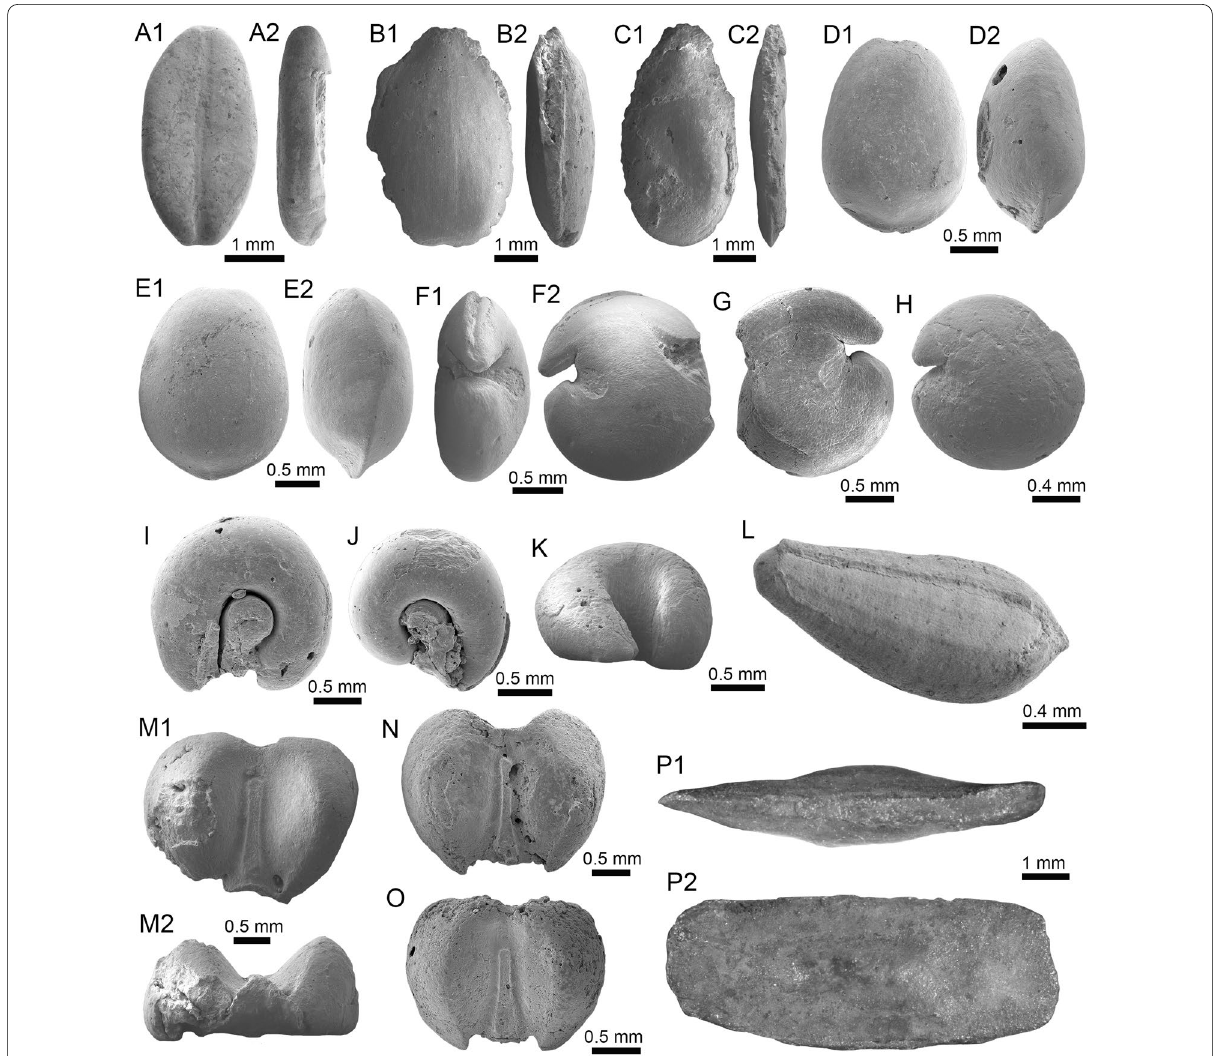
Fig. 33 Internal seed casts from the Norte Casa Chiguaje locality (Vergel Member). A1 , A2 Morphotype 1 (AMU‑PB‑02), Poaceae aff . Chloroideae. B1 – C2 Morphotype 2 (AMU‑PB‑03), Cucurbitaceae. D1 – E2 Morphotype 3 (AMU‑PB‑04), of indeterminate affinities. F1 – H Morphotype